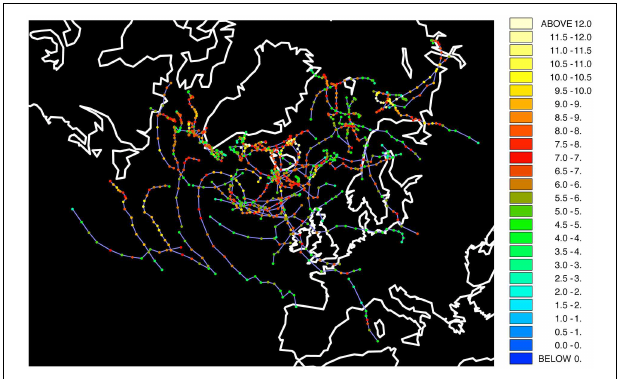
FIGURE 6 | Mesocyclones and polar lows in winter 1986/1987 from NCEP-CFSR data and tracked through Hodges’ TRACK algorithm. Colors represent strength as based on vorticity. Units: 10 − 5 s − 1 .